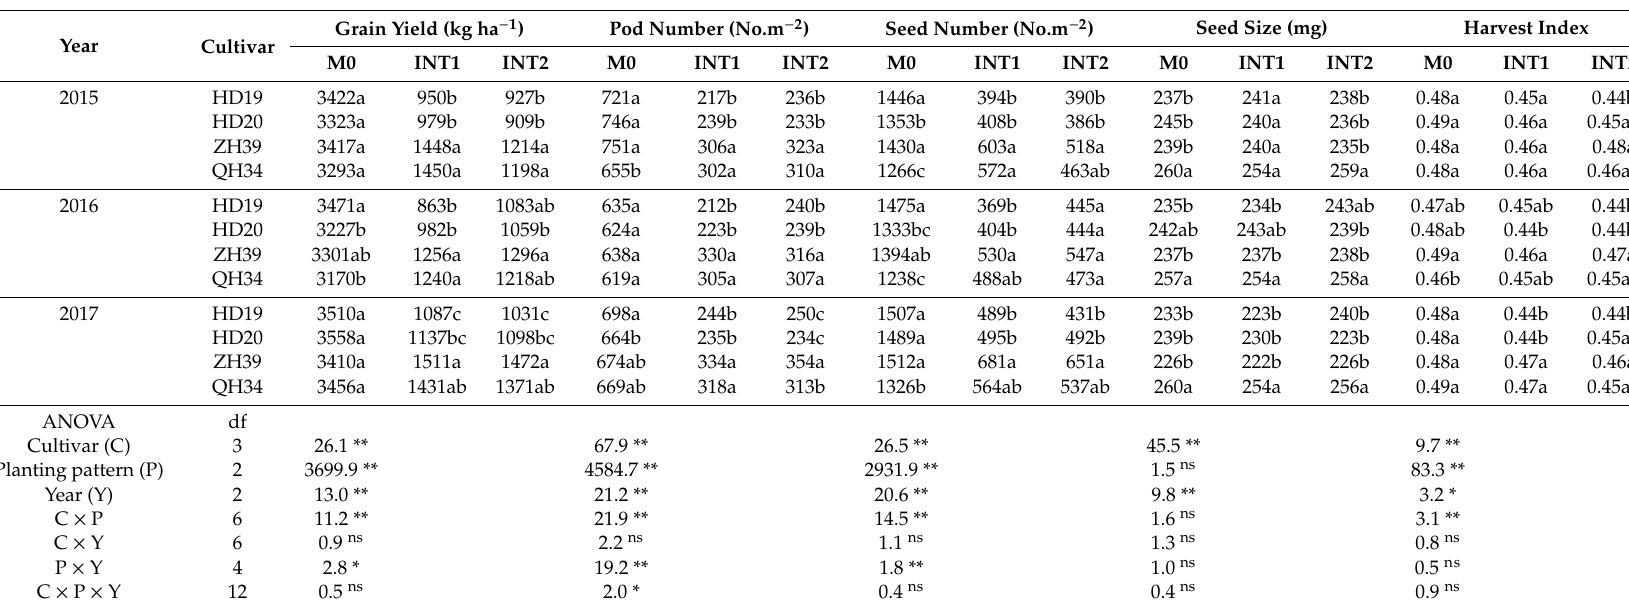
Table 3. Analysis of variance of grain yield and yield components among soybean cultivars under the di ff erent planting patterns during